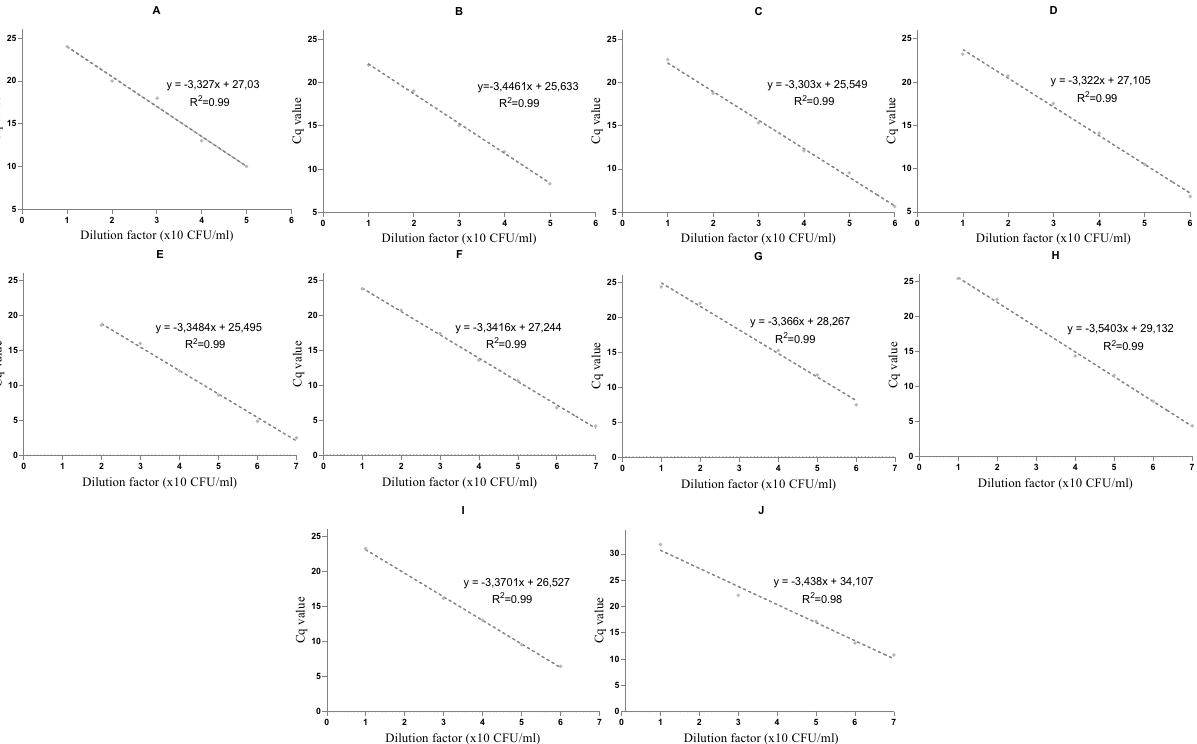
Figure 1. Standard curves constructed from duplicate serial dilutions to derive the linear equation, efficiency, and reproducibility for each serogroup 6, 18 and 22 assay-set. Panel A shows the culture standard for serotype 6B assessed with the assay-set to detect 6A/B/C/D; panel B is 6A assessed with the 6A/C assay-set; panel C is 6C assessed with the 6C/D assay-set; panel D is 6D with the 6C/D assay-set; panel E is 18C with the 18A/B/C/F assay-set; panel F is 18C with the 18B/C/F assay-set; panel G is 18C with the 18C/F assay-set; panel H is 18F with the 16F/18F/28A/F assay-set; panel I is 22A with the 22A/F assay-set and panel J is 22F with the 22F assay-